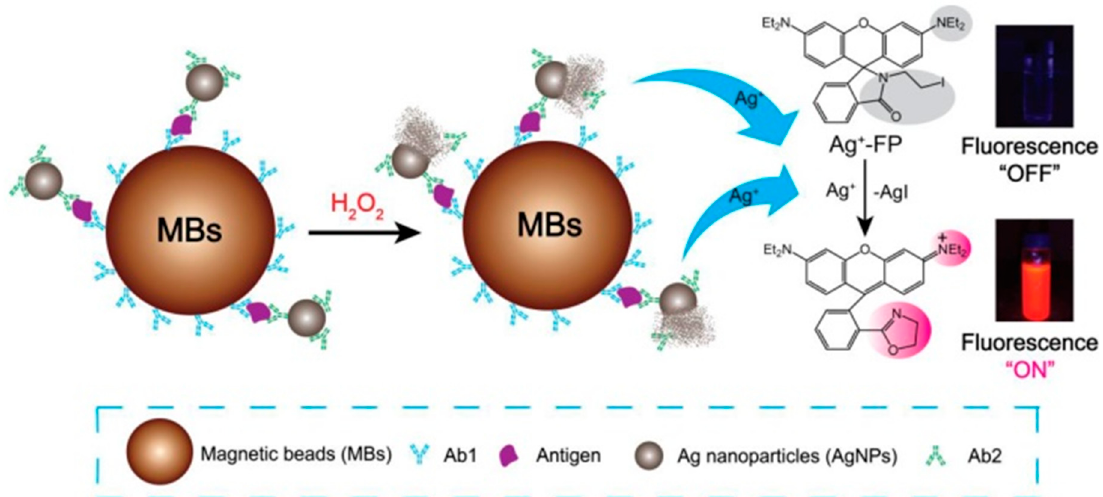
Figure 5. Schematic illustration of Ag + triggered fluorescence detection for protein biomarkers. Reprinted with permission from Theranostics, 2017. 7(4) p. 876–883. [95].